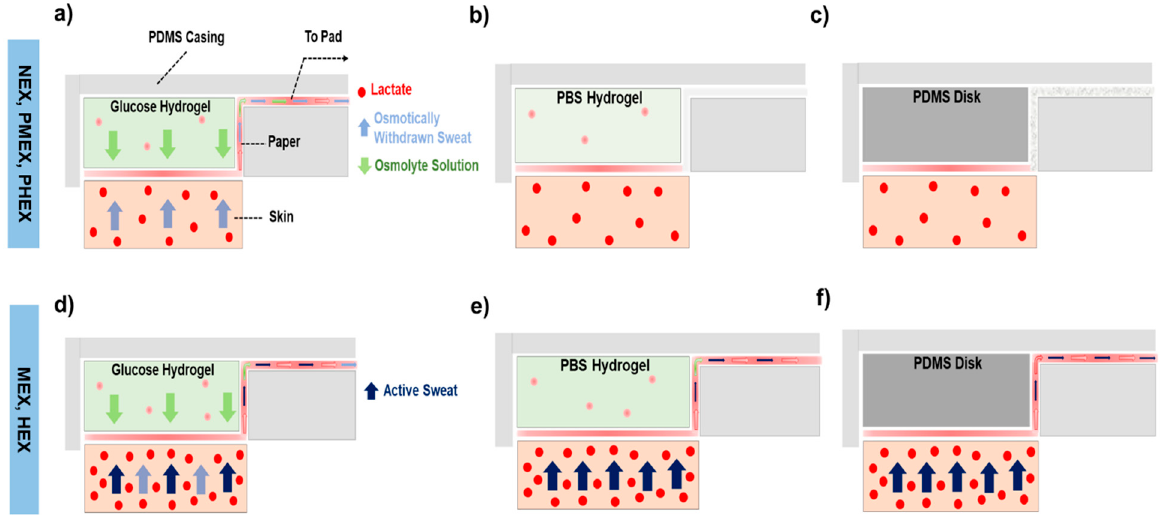
Figure 4. Cross-sectional schematics of sweat lactate transport with different pumping materials at the interface with the skin. The pumping materials include ( a ) a 4 M glucose hydrogel patch, ( b ) a PBS hydrogel patch, and ( c ) a PDMS disk patch during HEX, PMEX, and PHEX trials. Schematic showing the sweat lactate transport in ( d ) a 4 M glucose hydrogel patch, ( e ) a PBS hydrogel patch, and ( f ) a PDMS disk patch during MEX and HEX trials. These schematics show that the osmotic sampling of lactate occurs only in a 4 M glucose hydrogel patch. The PBS hydrogel patch and PDMS disk patch sample lactate from active